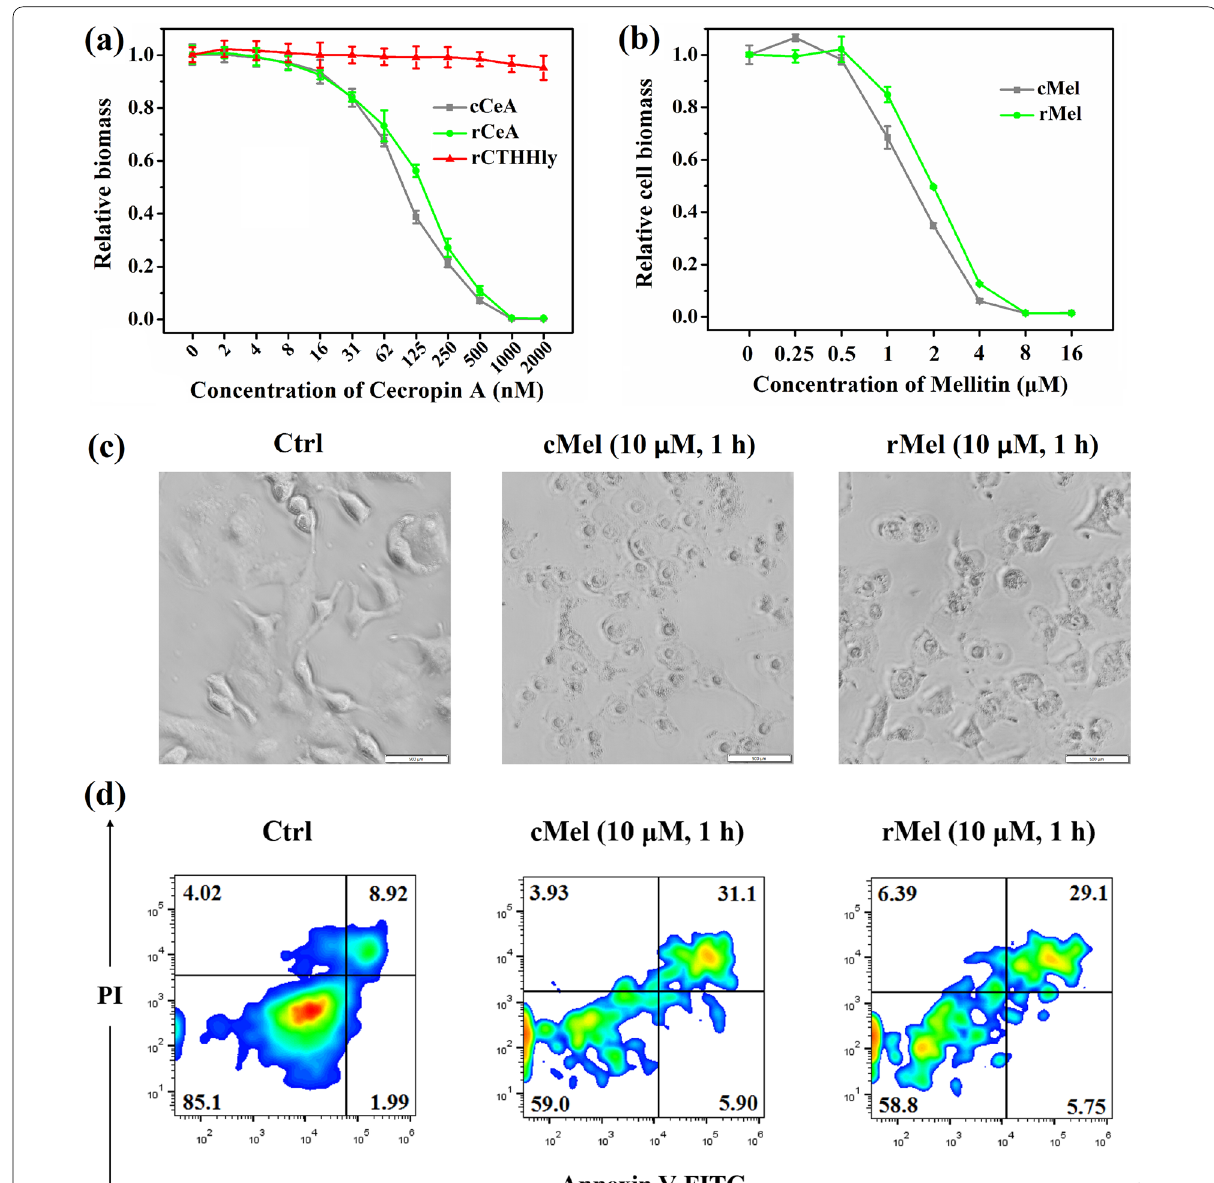
Fig. 7 Determination of the anti-microbial/anti-tumor activity of rCeA/rMel. a , b Comparison of the anti-microbial activity of rCeA/cCeA ( a ) and anti-tumor activity of rMel/cMel ( b ). c , d Comparison of the tumor lysis capacity ( c ) and pro-apoptosis effects of rMel and cMel ( d ). E. coli 25,922 cells were incubated with different concentrations of cCeA and rCeA for 18 h, then the OD600 values were measured. A549 cells were incubated with different concentrations of cMel and rMel for 8 h, the numbers of living cells were detected with CCK8 reagent. For apoptosis detection, A549 cells were incubated with 10 μM melittin for 1 h, and subsequently labeled with Annexin V-FITC/PI and analyzed with a CytoFlex